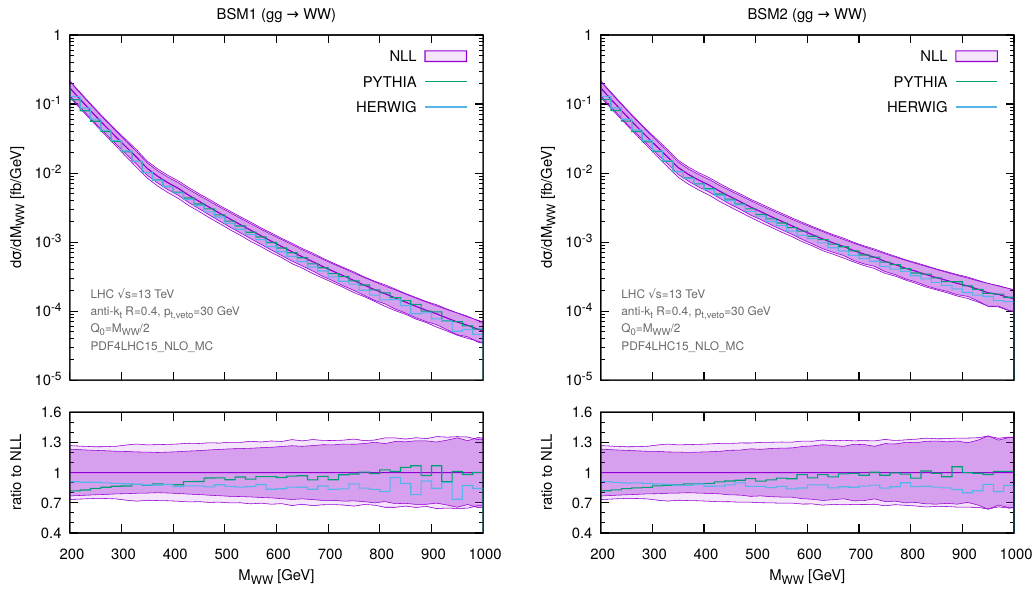
Figure 8 . The same distribution as in figure 7 for the two BSM scenarios considered in the main